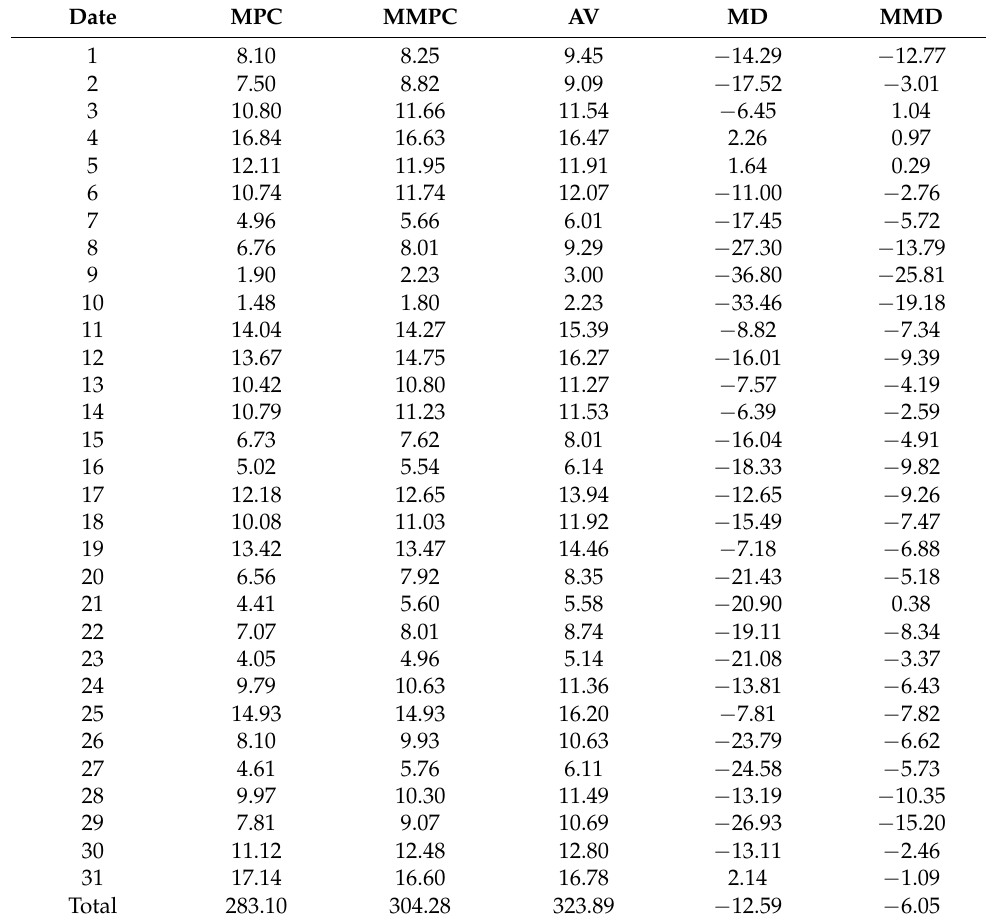
Table 4. Comparison of Diurnal electric quantity (MW · h,